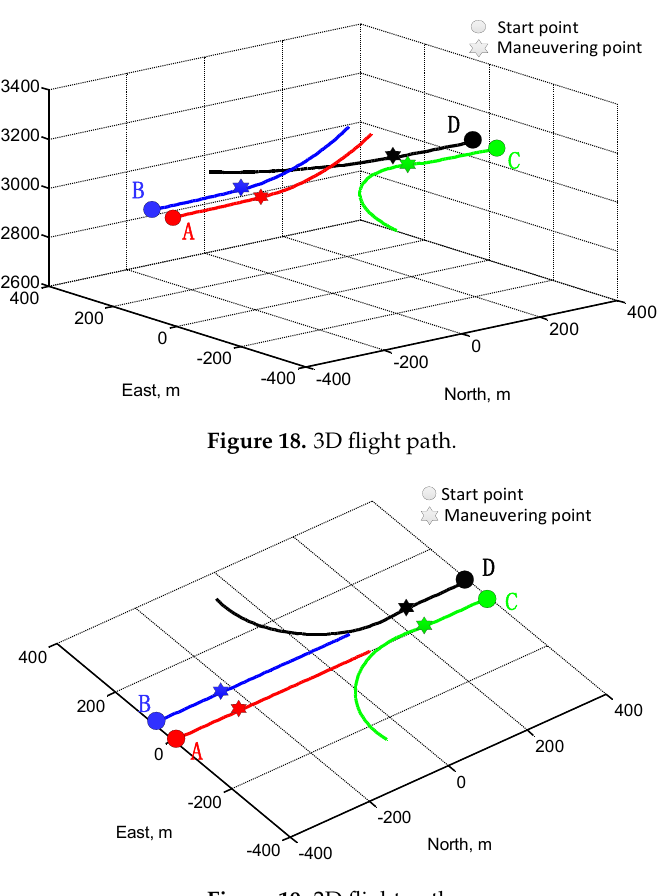
Figure 19. 2D flight path.